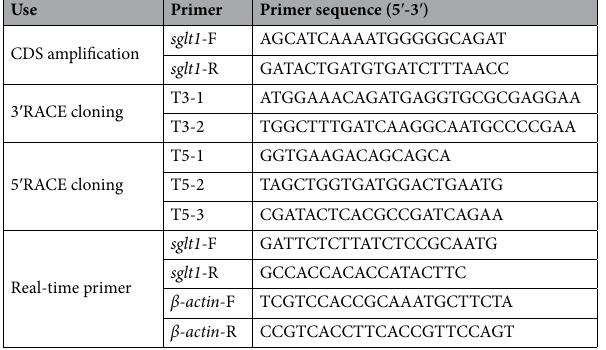
Table 1. Sequences of the PCR primers used in this work. sglt1 , sodium-dependent glucose cotransporter